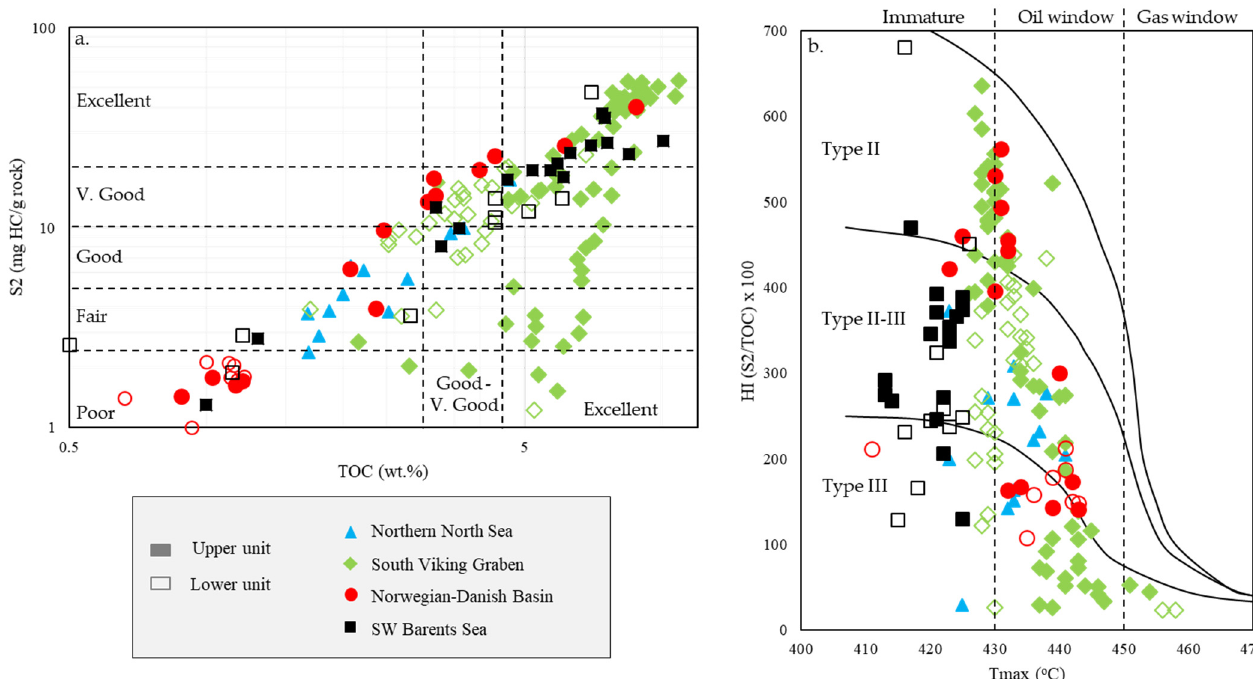
Figure 2. Geochemical illustration of the database from the studied area: ( a ) Cross-plot of TOC (total organic carbon) versus S2 (quantity of hydrocarbons generation potential the rock has during maturation) of upper and lower units comparing the quality of the organic matter within different sub-basins. The background template is modified from [55]. ( b ) Pyrolysis T max (the temperature at which the maximum rate of hydrocarbon generation occurs during pyrolysis analysis) versus HI (Hydrogen Index = [S2/TOC] × 100) of the same data points, showing the kerogen type and thermal maturity, according to [56].